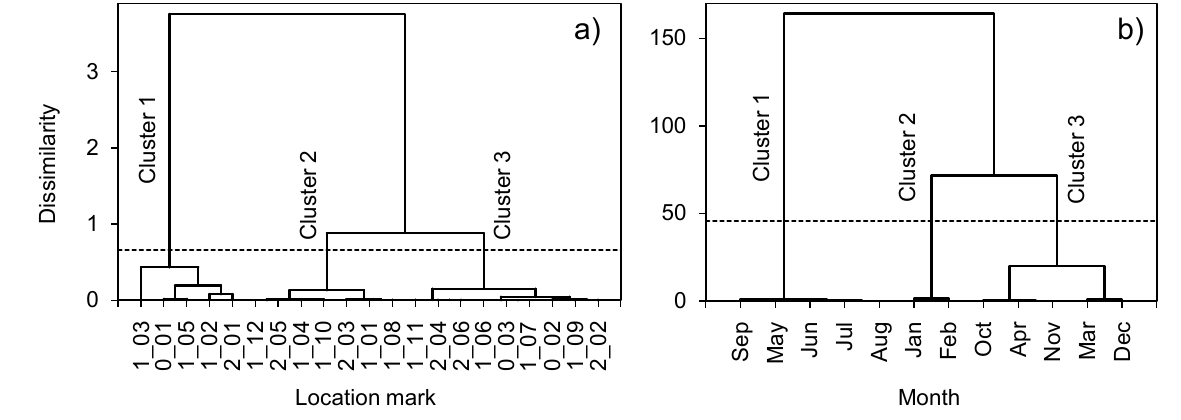
Figure 7. ( a ) Spatial and ( b ) temporal dendrogram of TN, TP, and TN:TP mass ratio.